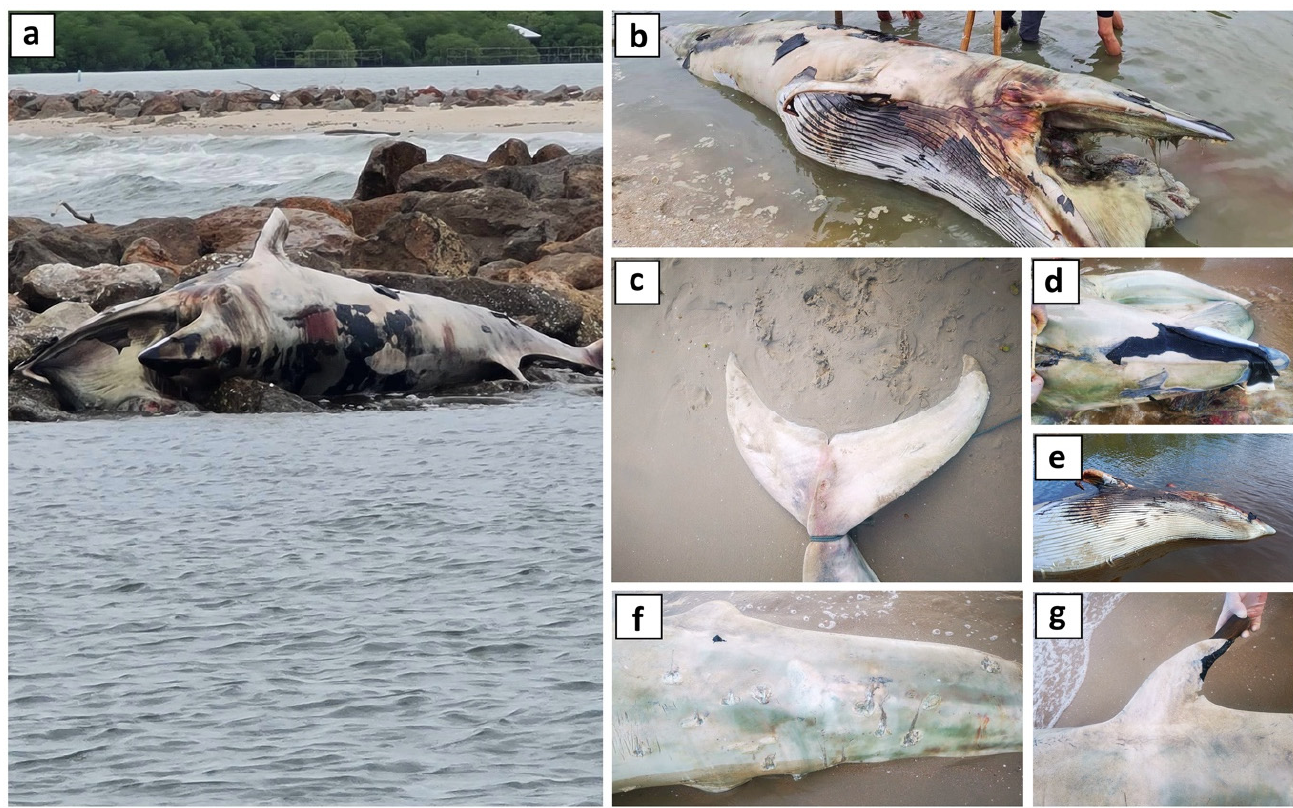
Figure 2. External morphology of a stranded, unknown male whale, 5.27 m, found at Laem Phak Bia, Phetchaburi, the Gulf of Thailand, Thailand (13.060762, 100.105103) in September 2022. ( a ) Whale at the stranding site; ( b ) overall appearance; ( c ) fluke; ( d ) dorsal view of the head; ( e ) ventral view of the body; ( f ) lateral view of the caudal part of the body; and ( g ) dorsal fin. A phylogenetic tree of the D-loop sequence was constructed using Bayesian anal- ysis implemented in the program MrBayes version 3.2.7 [35]. Other D-loop